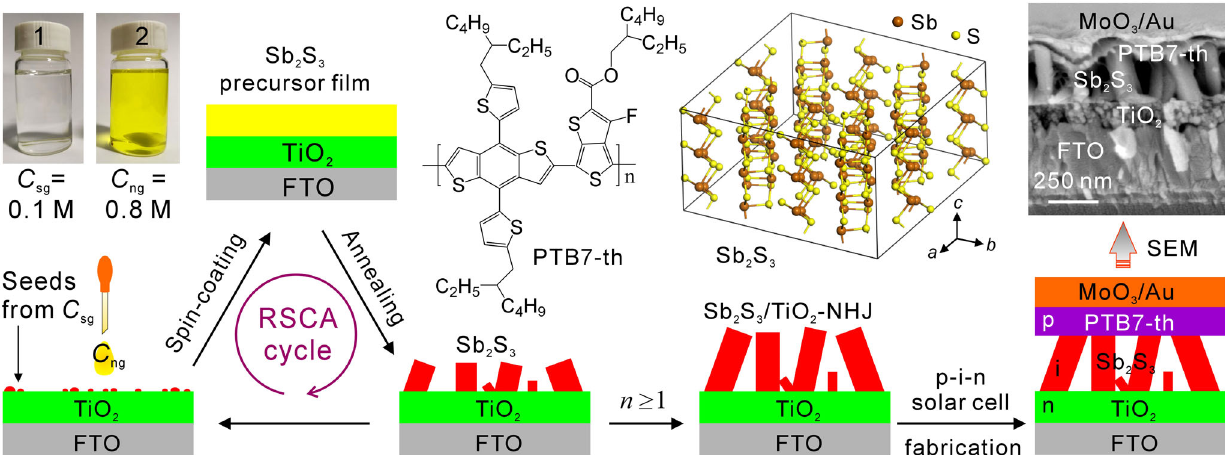
Fig. 1 Tiny-seed assisted repetition of spin-coating and annealing (RSCA) method, structures of materials, and device. The schematic illustration shows the preparation of the Sb 2 S 3 /TiO 2 -nanoarray heterojunction (Sb 2 S 3 /TiO 2 -NHJ) by a tiny-seed-assisted RSCA method on fl uorine-doped tin oxide (FTO) substrate and the structure of p – i – n solar cell, where p means p-type PTB7-th, i means intrinsic Sb 2 S 3 and n means n-type TiO 2 . The insets show the photographs of seed growth (bottle 1, colorless) and nanorod growth (bottle 2, yellow) solutions, the molecular structures of PTB7-th, the crystal structure of orthorhombic Sb 2 S 3 , and the cross-sectional scanning electron microscopy (SEM) characterization of a practical p – i – n cell. Normally, the seed growth solution concentration of C sg = 0.1 M and the nanorod growth solution concentration of C ng = 0.8 M were, respectively, used for growing the Sb 2 S 3 seeds prior to the RSCA cycles and the Sb 2 S 3 nanorods in the RSCA cycles, unless otherwise speci fi ed. During the RSCA method, each of the precursor fi lm formations by spin-coating followed by once annealing is referred to as one RSCA cycle for the nanorod growth, and the nanorod length (i.e., nanorod array thickness) is mainly controlled by the RSCA cycle number ( n